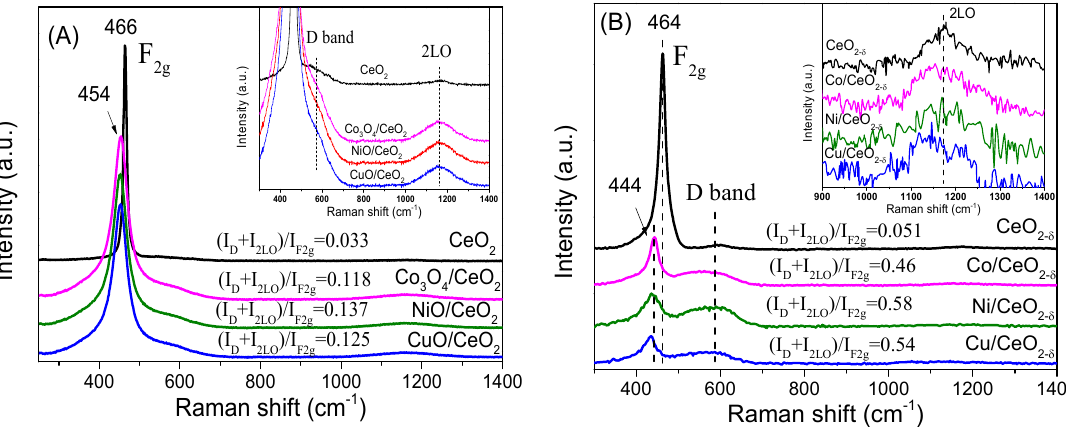
Figure 5. Raman spectra of the MO x /CeO 2 precursors ( A ) and the reduced M/CeO 2 − δ catalysts ( B ). The inserted zoom-in figures underline the existence of 2LO bands.